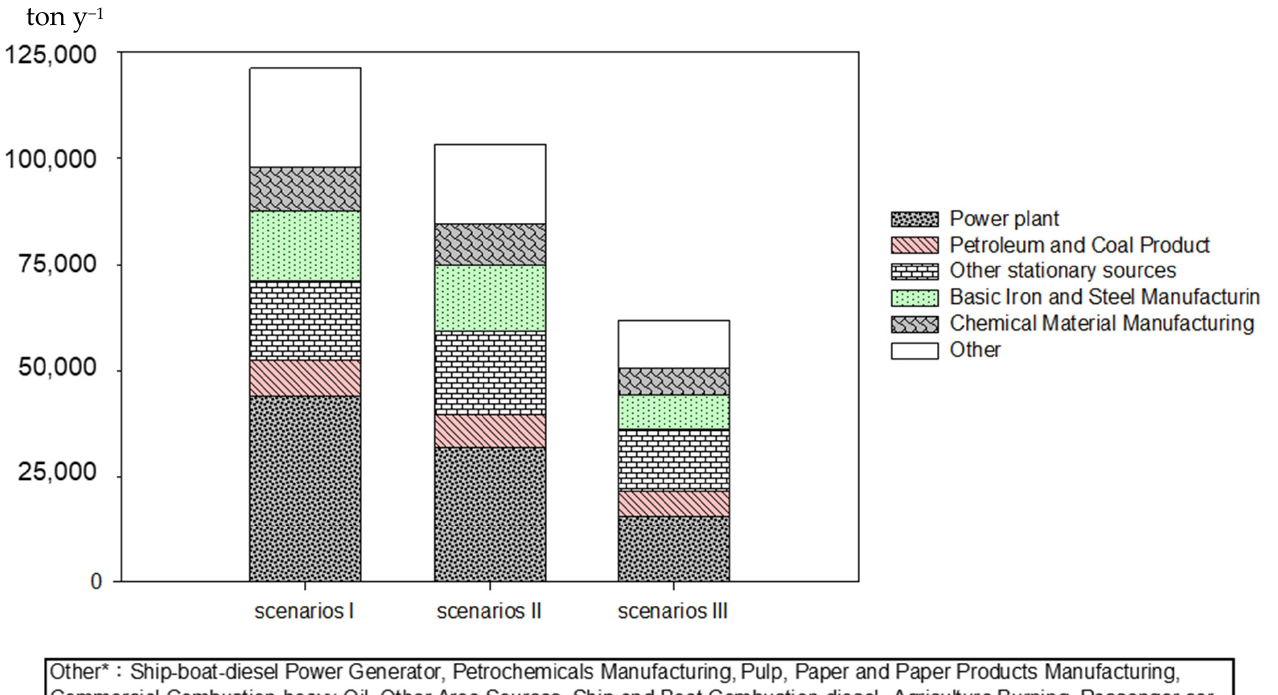
Figure 3. SO 2 emission sources for different scenarios (ton y − 1 ).